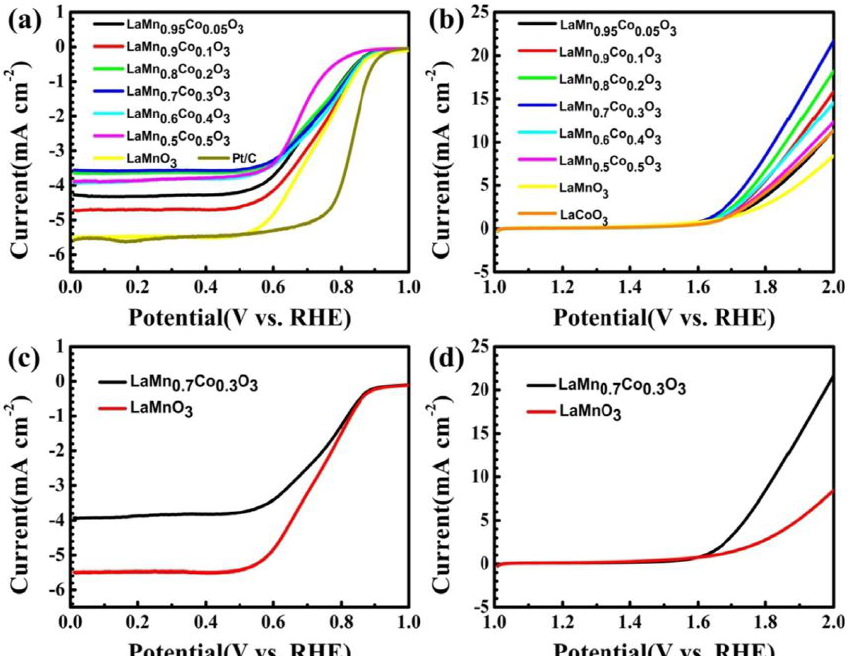
Figure 10. ( a ) The LSV curves of LaMn 1-x Co x O 3 and commercial 20 wt % Pt/C for the ORR at 1600 rpm. ( b ) The LSV curves of LaMn 1-x Co x O 3 and LaCoO 3 for the OER at 1600 rpm. The LSV curves of LaMn 0.7 Co 0.3 O 3 and LaMnO 3 for the ORR ( c ) and OER ( d ) at 1600 rpm. Copyright 2018 by the Wiley-VCH Verlag, GmbH & Co. KGa, Weinheim [80].